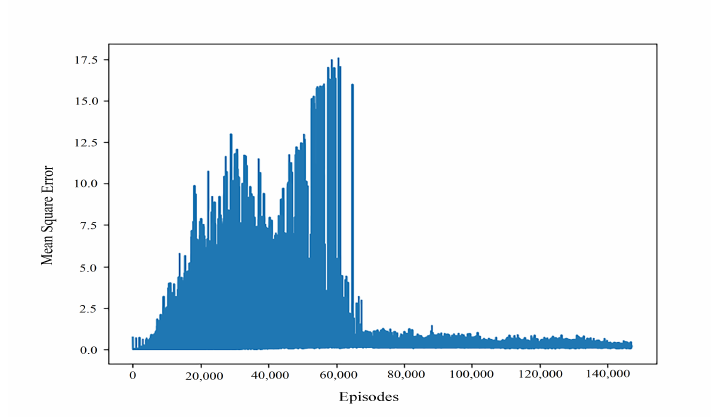
Figure 8. Variation of the mean square error in dynamic learning